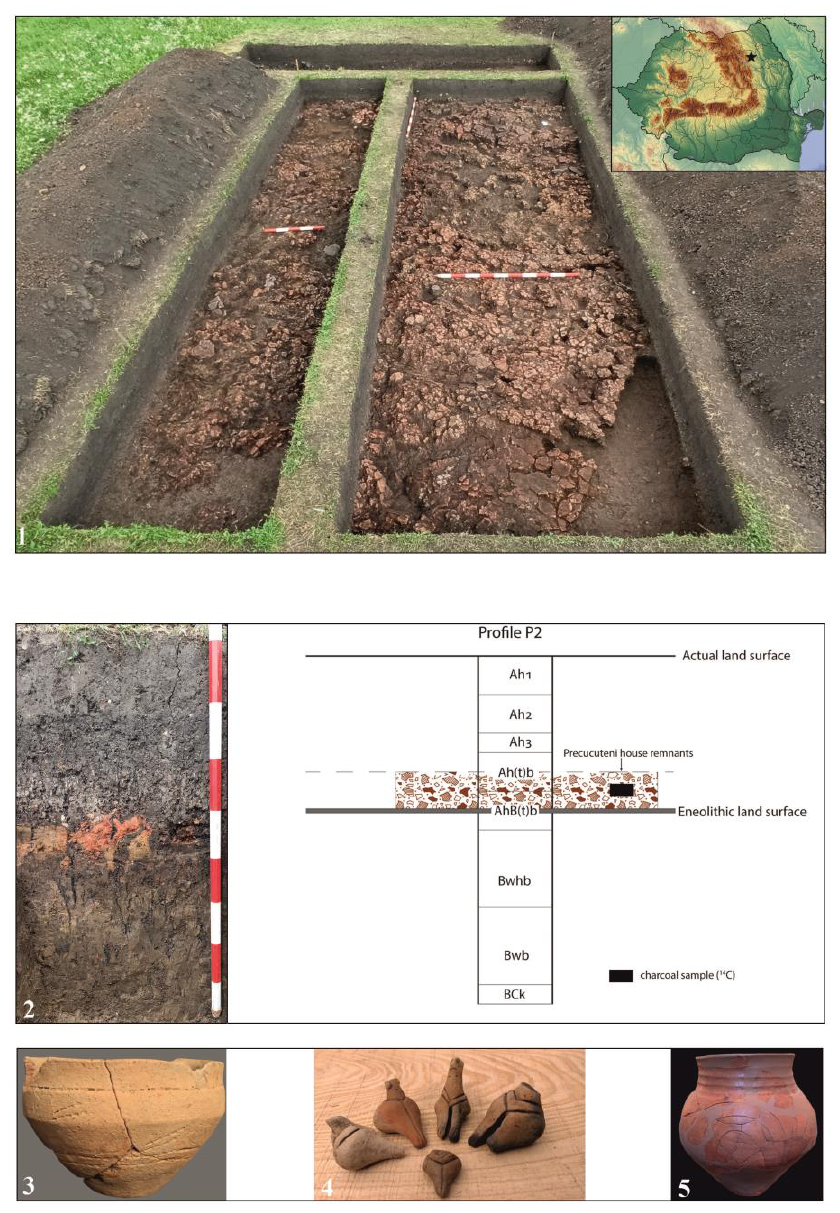
Figure 1. The site from Topoli ț a: ( 1 ) Dwelling no. 4; ( 2 ) pedological sequence; ( 3,5 ) pottery; ( 4 ) an- thropomorphic figurines.